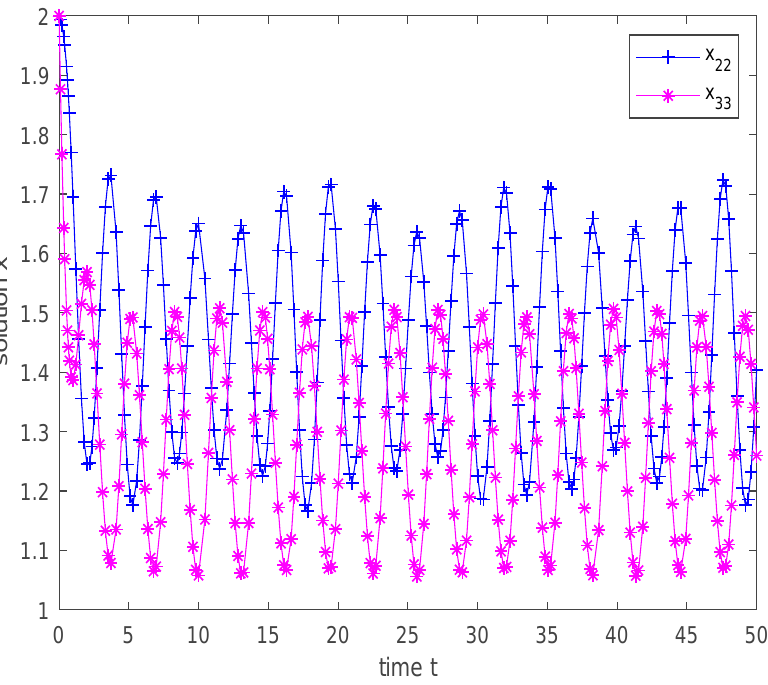
x and x , and initial values are Figure 6. The state trajectory of x 22 and x 33 , and initial values are x 22 ( 0 ) = x 33 ( 0 ) = 2.0. Figure 6. The state trajectory of 22 33 Figure 7a,b demonstrates the phase responses of state variables x 11 ( t ) and x 22 ( t ) for the neural network system (15) with different initial values ( 4.0, 2.5 ) , ( 1.0, 0.5 ) . Figure 7c describes the space behavior of the state variables x 11 ( t ) , x 22 ( t ) for the neural network system (15). Similarly, Figure 8a,b shows the phase responses of state variables x 11 ( t ) and x 33 ( t ) for the neural network system (15) with different initial values ( 3.5, 1.0 ) , ( 0.5, 1.5 ) . Figure 8c space behavior of the state variables x 11 ( t ) , x 33 ( t ) for the neural network sys- tem (15); and Figure 9a,b depict phase diagram x 22 ( t ) and x 33 ( t ) with ( 2.0, 1.5 ) , ( 0.5, 1.0 ) , Figure 9c reveals the space behavior of the state variables x 22 ( t ) and x 33 ( t ) . Figure 7d, Figure 8d, and Figure 9d exhibitions the 3D space behavior of the state variables x 11 ( t ) , x 22 ( t ) and x 33 ( t ) for the neural network system (15) with three different initial values ( 0.5, 1.0, 0.5 ) , ( 0.5, 1.5, 1.5 ) , ( 0.5, 2.5, 1.5 ) . The time response confirms that